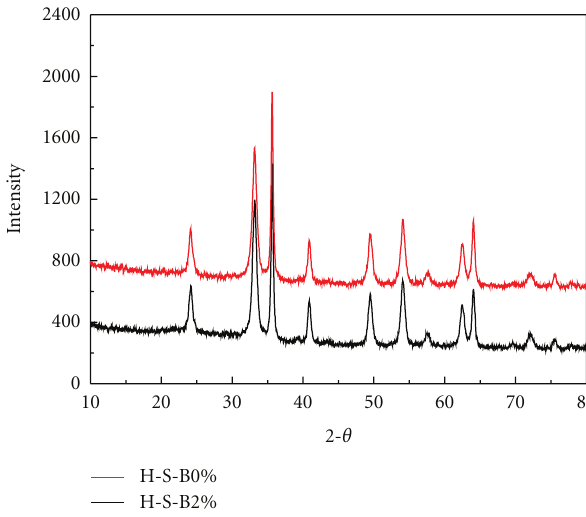
Figure 1: X-ray di ff raction patterns of goethite and B-doped goethite.